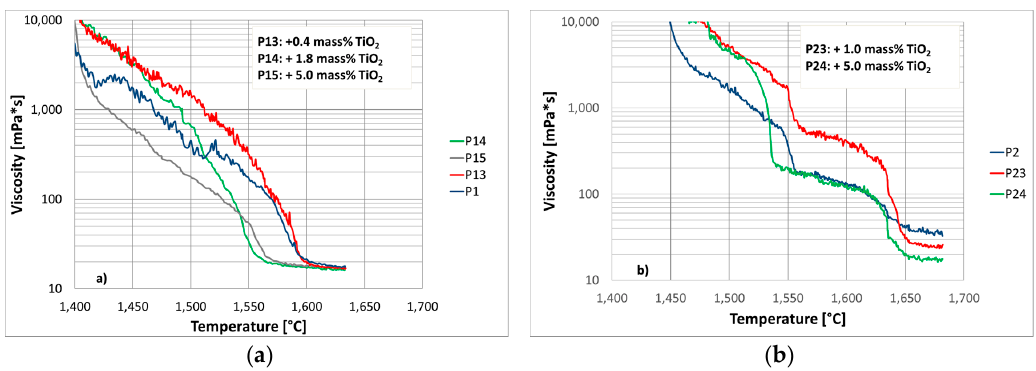
Figure 5. Viscosity of the BOF slag with 2 ( a ) and 8 mass% of MgO ( b ) as function of TiO 2